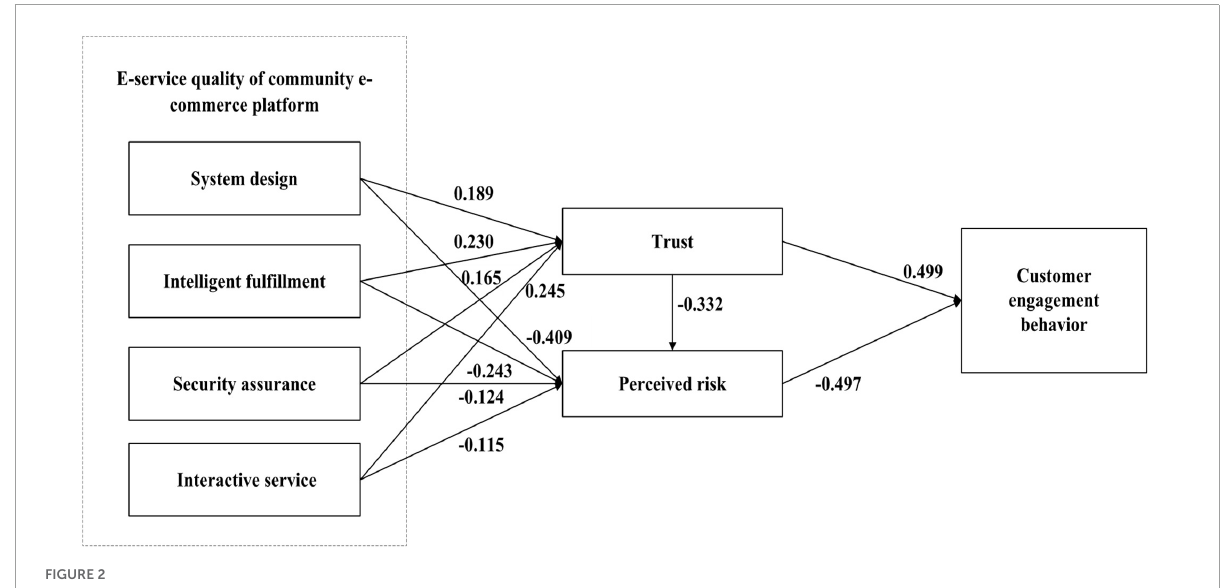
FIGURE2 Model testing